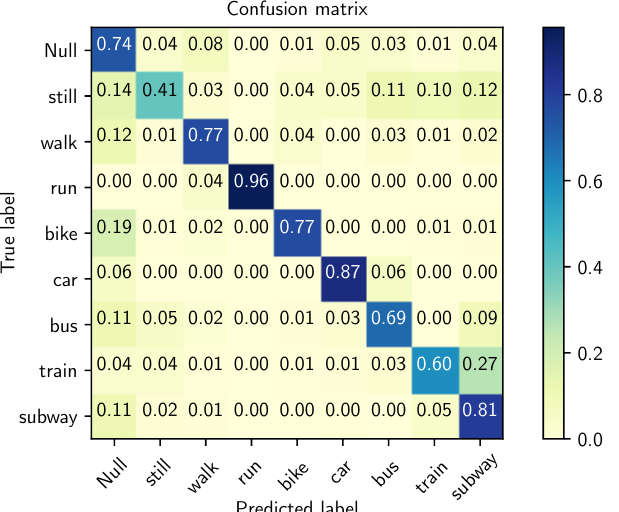
Figure 18. Confusion matrix of the best model trained on all body locations fused together yielding 70.86% recognition performance measured by the f1-score. Best model among the set of models evaluated as part of a Bayesian optimization process involving the hyperparameters of the activity recognition